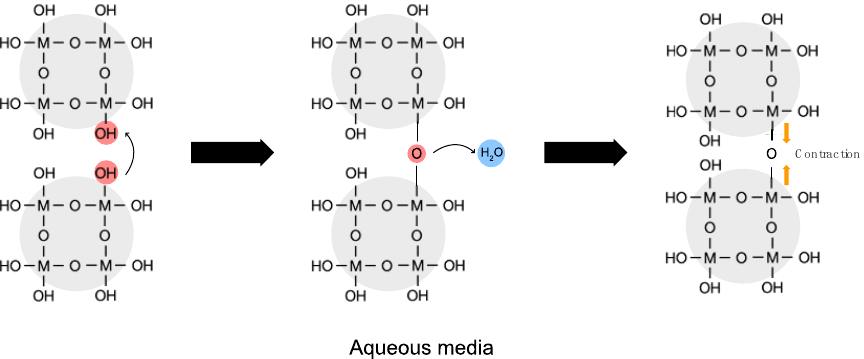
Figure 5. Polycondensation between two polymerized particles and the shrinking of the oxo bond.